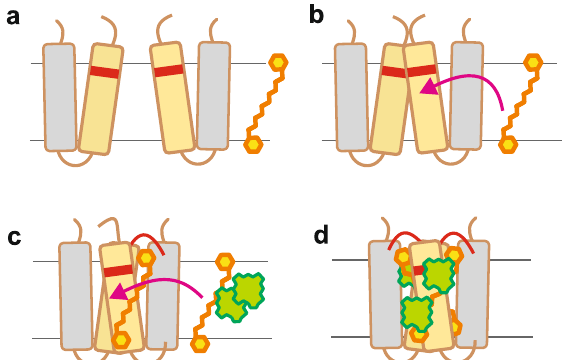
Fig. 6 A scheme of pigment binding to LIL3 protein. LHC-like proteins, which contain only a single ‘ Hlip helix ’ (Hlips, OHPs, SEP/LIL3) have to dimerize to be able to associate with pigments. Although LIL3 is stable as a monomer ( a ) and can dimerize without pigments, the pigmentless dimer readily dissociates ( b ). A transient attachment of carotenoid molecules to LIL3 dimer is a precondition for the Chl-binding; in the absence of xanthophylls, Chl molecules cannot be ligated by the ExxNxR motif ( c ). On the other hand, the associated Chls enclose the carotenoid-binding cavity (see also Fig. 5d), and therefore the successive binding of carotenoids and Chls on each side of the dimer is essential for the establishment of a stable pigment-protein complex ( d